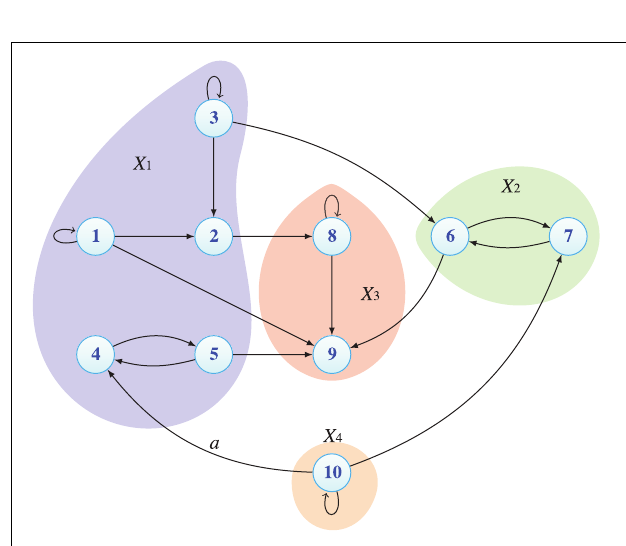
FIGURE 3 | Connectivity diagram for Example 2 portraying how the bock sets. Note the effect of the value of the a parameter on cDC ( Figure 5 versus Figure 6